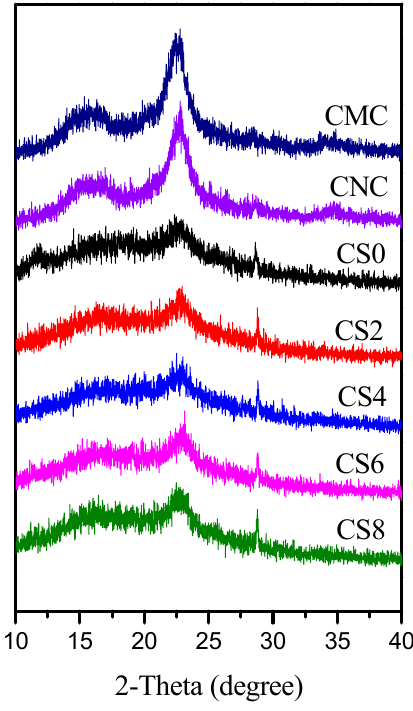
Figure 3. XRD of CMC, CNC CS0, CS2, CS4, CS6, and CS8 samples.